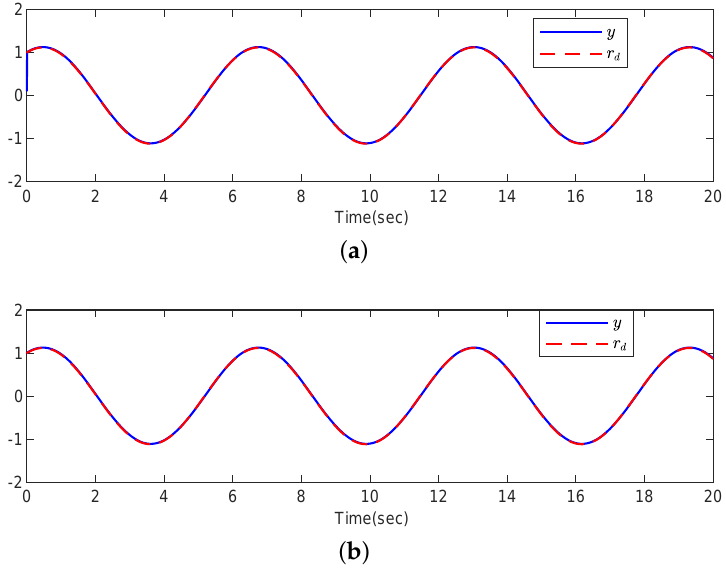
Figure 2. ( a ) The trajectories of y ( t ) and r d ( t ) under case 1 . ( b ) The trajectories of y ( t ) and r d ( t ) under case 2